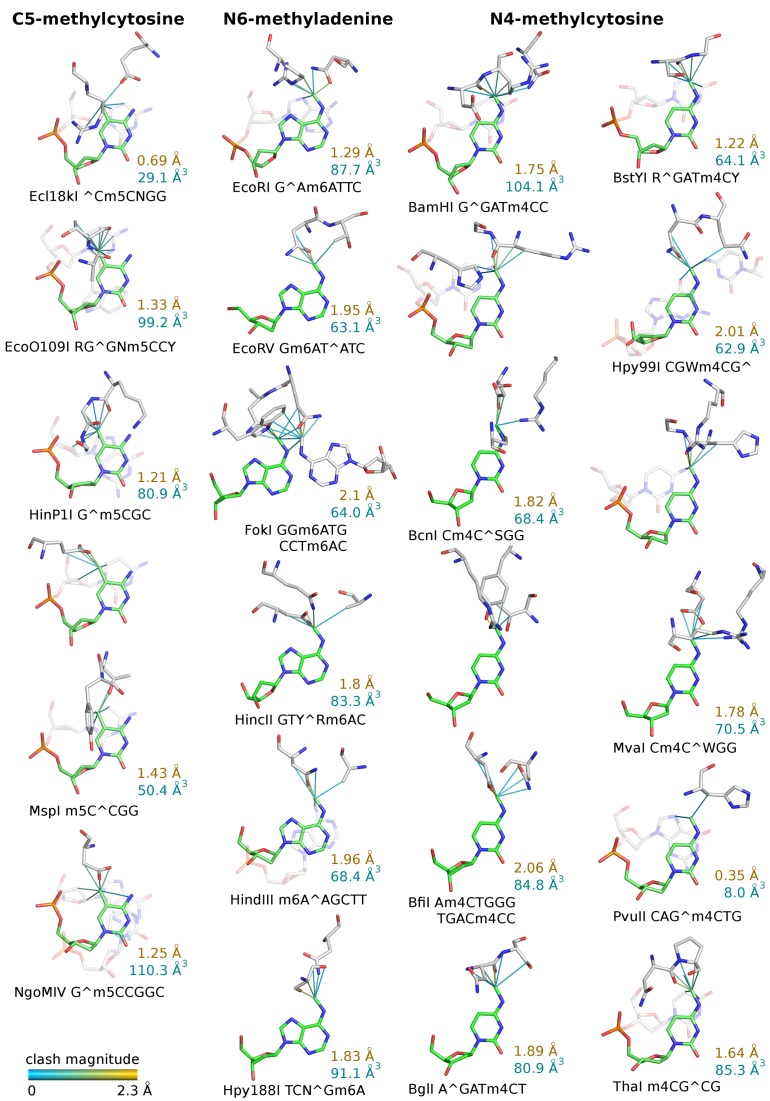
Clashes of protective methyl groups introduced by cognate methyltransferases with the protein and DNA atoms in the restriction endonuclease–DNA complex structures. The clashes are colored according to their magnitude (from cyan to yellow for least to most severe overlap). The MunI structure has been omitted due to high similarity to EcoRI endonuclease, particularly pronounced in the methyl group environment. The position and type of cognate methylation is indicated in restriction enzyme target sequences (∧ marks the cleavage site). The magnitude of the most severe clash and the cumulative volume clash is shown in yellow and cyan, respectively.